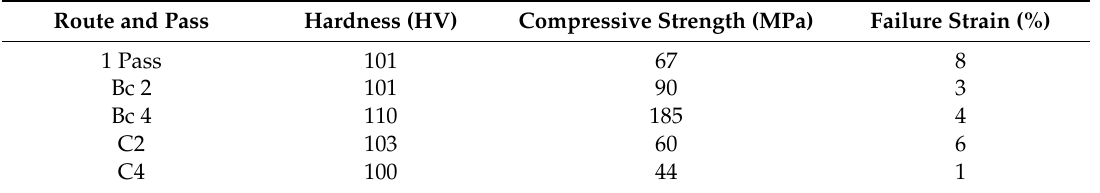
Table 4. Vickers hardness, compressive strength and failure strain of ECAPed samples. Route and